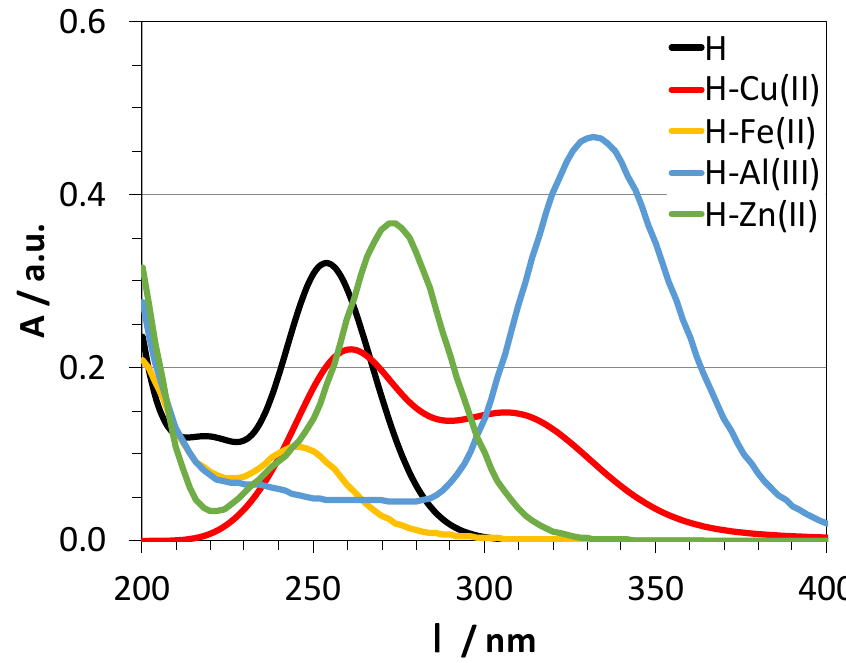
doublet while all other metal ions’ spin multiplicity is singlet.